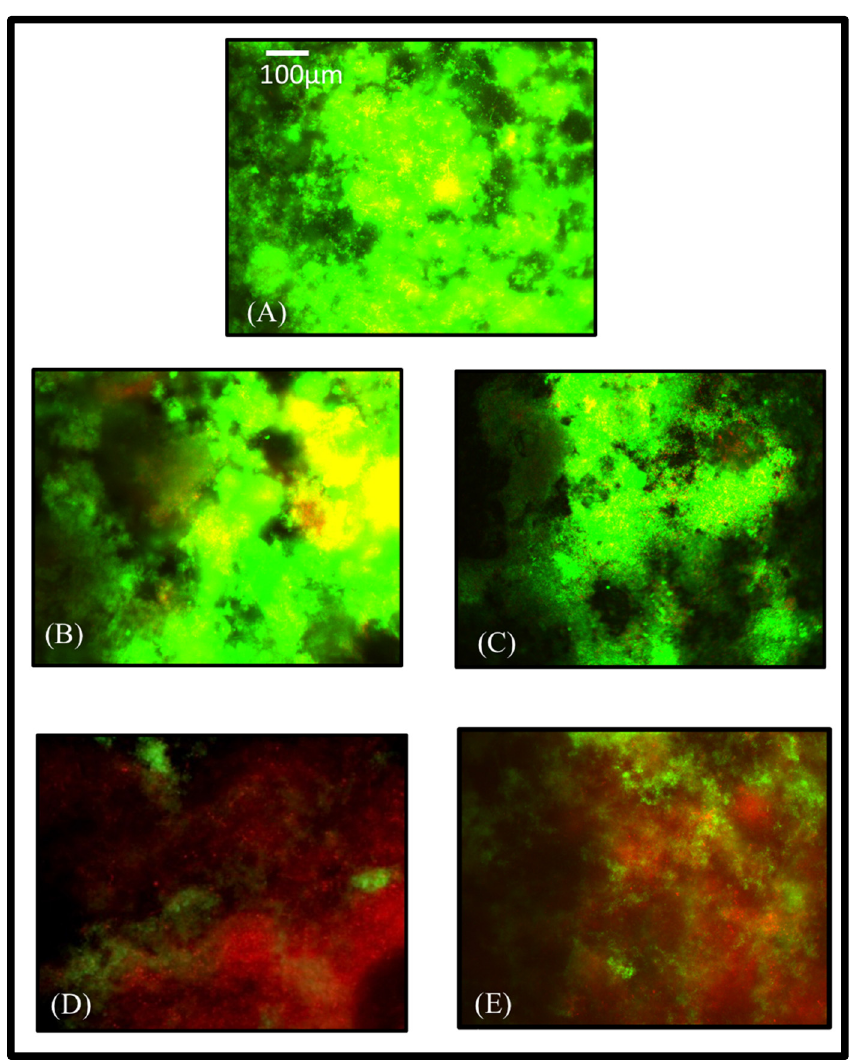
Figure 6. Representative live/dead staining images of biofilms: ( A ) commercial control, ( B ) experimental control, ( C ) NACP group, had no antibacterial agent, and the bacteria was alive (in green). ( D , E ) had 5% DMHADM, showed dead bacteria (in red). Commercial Control composite (High- viscosity Sealant/Flowable Composite Virtuoso, DenMat, Lompoc, CA, USA), 50% UV + 50% glass (Experimental Control composite), 45% UV + 20% NACP + 35% glass (UV + NACP composite), 45% UV + 5% DMAHDM + 50% glass (UV + DMAHDM composite), 45% UV + 5% DMAHDM + 20% NACP + 30% glass (UV + DMAHDM + NACP + 30glass), * UV indicates low-shrinkage-stress resin composed of UDMA + TEG-DVBE. Adapted with permission from reference [110]. Copyright 2021 Elsevier.